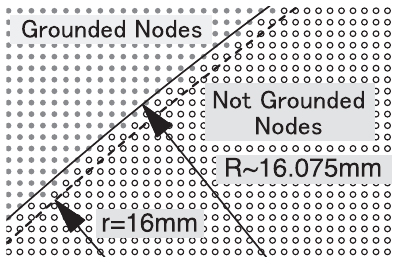
FIG. 8. Grounded nodes set outside by one or more nodes.